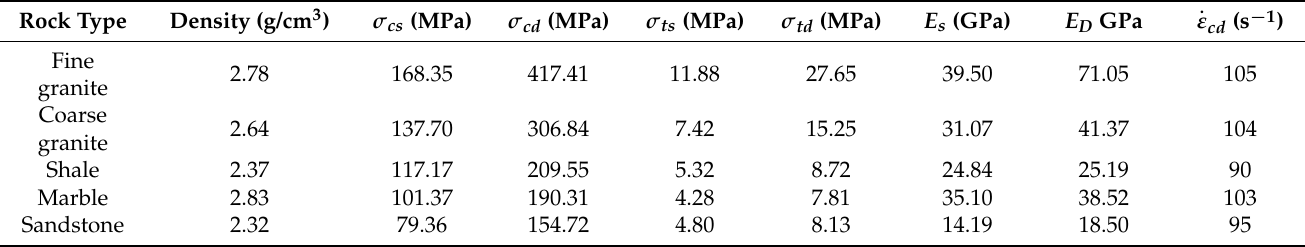
Table 2. The average physical and mechanical parameters of rock specimens ( σ cs is uniaxial com- pressive strength; σ cd is dynamic compressive strength; σ ts is static Brazilian splitting strength; σ td is dynamic Brazilian splitting strength; E S is the static elastic modulus; E D is the dynamic elastic . ε cd is the strain rate of the specimens in a dynamic compressive modulus;